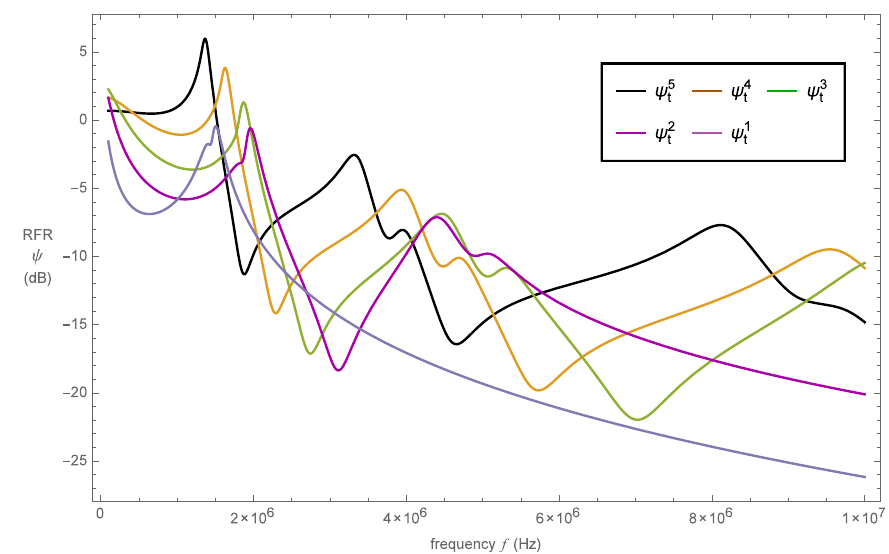
Figure 5. Non-dimensionalized reception force response (RFR) ψ (dB) versus frequency f (Hz) for the Sierpinski tetrix fractal-inspired sensor at fractal generation levels one to five.